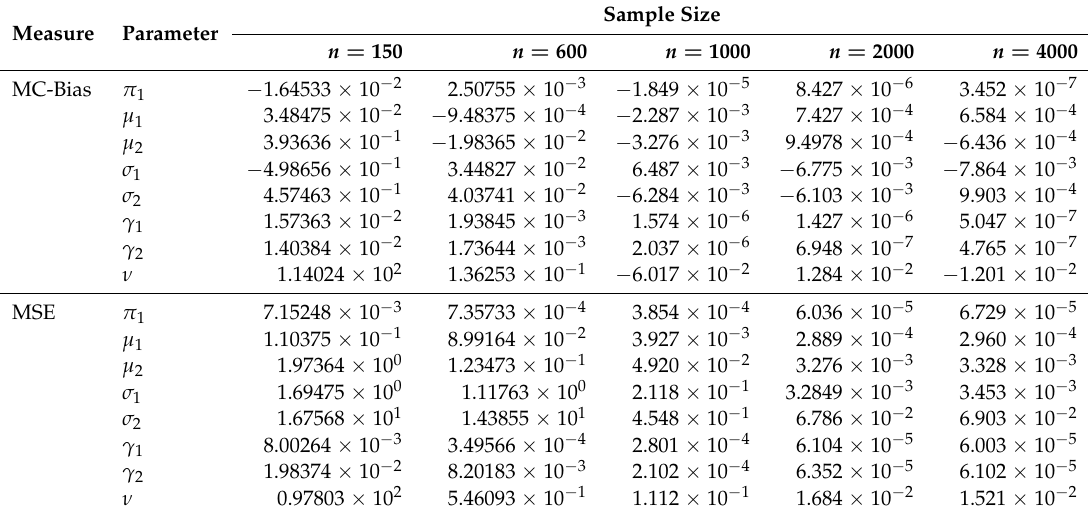
Table 3. Monte-Carlo average bias (MC-bias) and mean squared error (MSE) for maximum likelihood (ML) estimates in the weak separated components (WS) FM-TP-true (T) model.